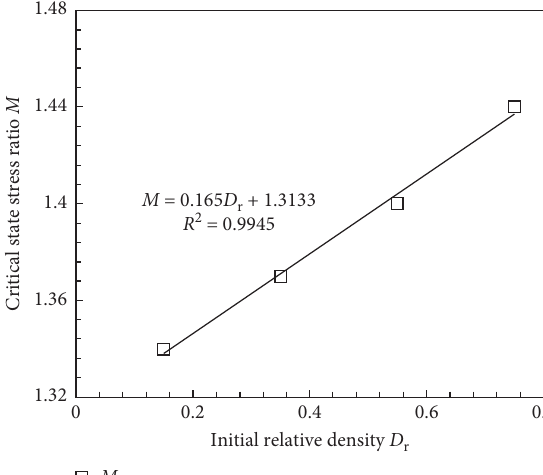
Figure 14: Relationship between D